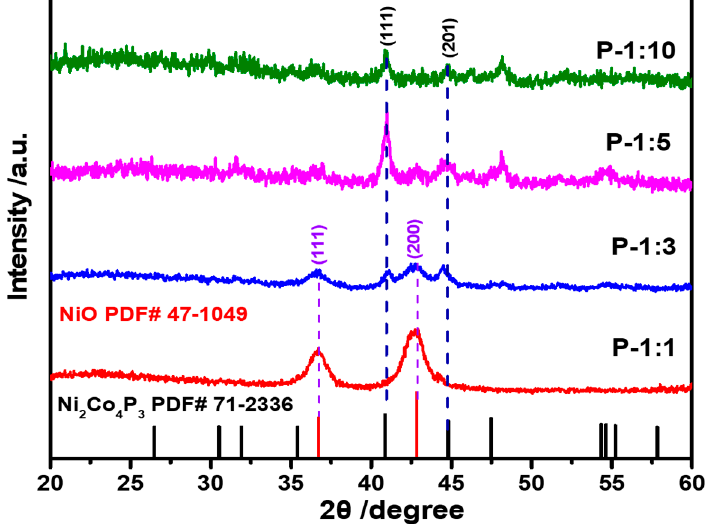
Figure 1. XRD pattern of Ni-Co-P samples with different ratio from 1:1, 1:3, 1:5, and 1:10.